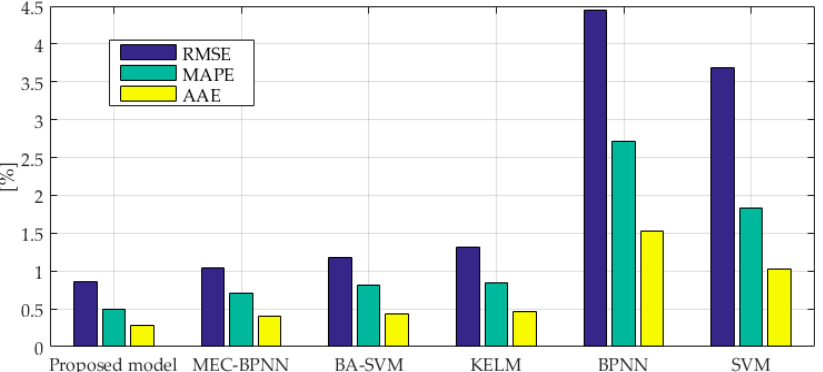
Figure 6. Values of root-mean-square error (RMSE), mean absolute percentage error (MAPE) and average absolute error (AAE).